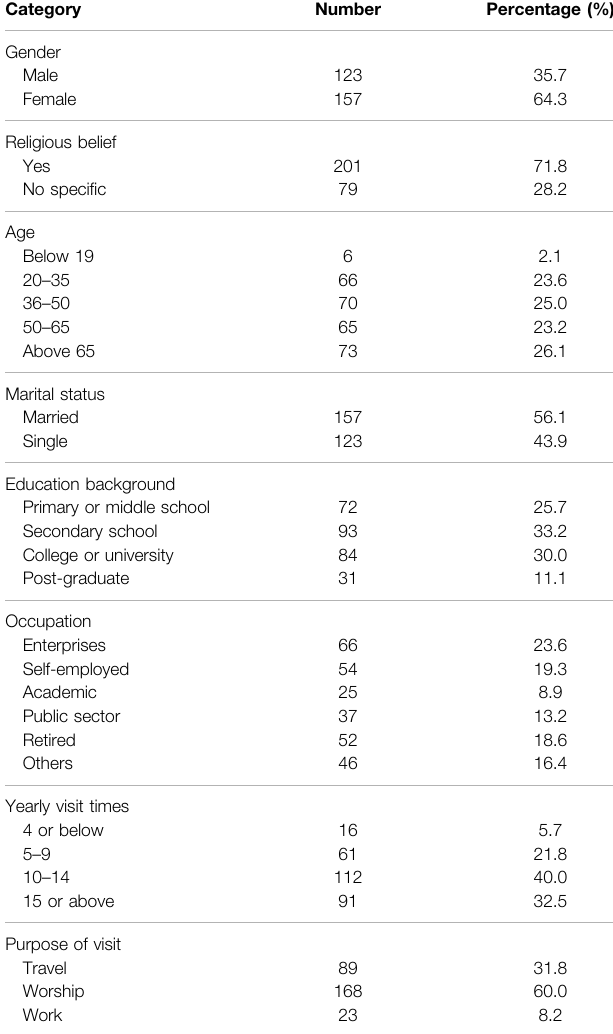
TABLE 1 | Pro fi le of respondents ( n =